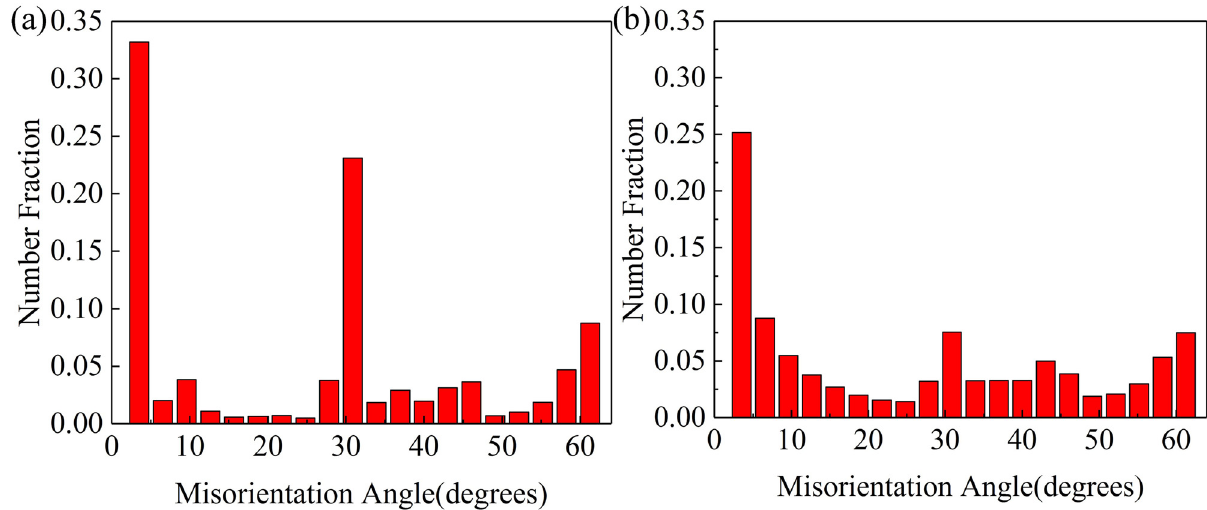
Figure 11: Misorientation angles of the samples by hot deformation at temperature of 950°C: ( a ) 0.1 s − 1 and ( b ) 5 s − 1